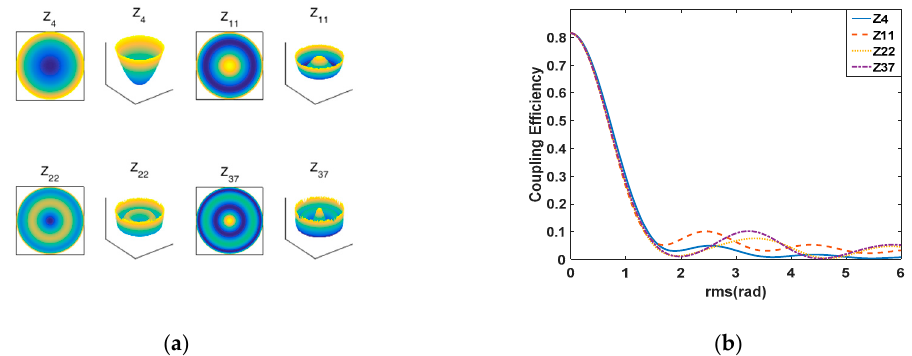
Figure 3. ( a ) Circularly symmetric aberration patterns; ( b ) CE with the circularly symmetric